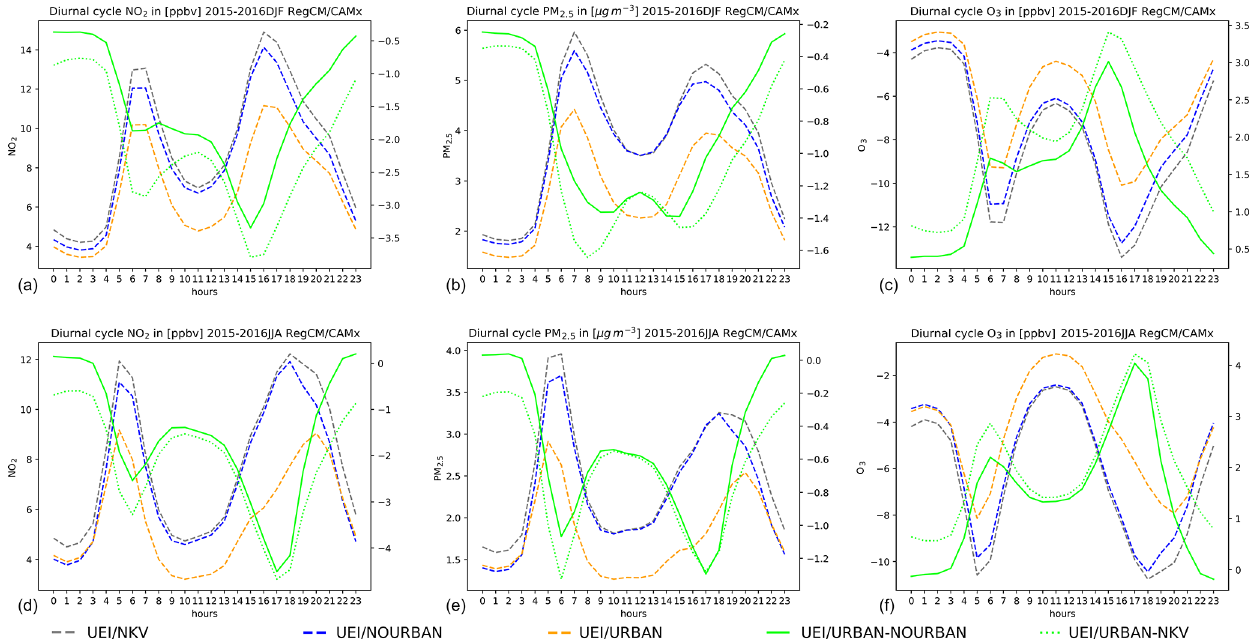
Figure 15. Impact of considering the vertical eddy diffusion (Kv) on the urban emission impact ( (cid:49) UEI) calculated from RegCM/CAMx simulations for DJF (a–c) and JJA (d–f) for NO 2 (a, d) , PM 2 . 5 (b, e) and O 3 (c, f) . Dashed grey, blue and green lines stand for the UEI calculated from the NKV, NOURBAN and URBAN cases, respectively, and belong to the left y axis. Solid and dotted green lines denote the (cid:49) UEI as the difference between the URBAN and NOURBAN and between the URBAN and NKV cases. Gases is in parts per billion volume (ppbv) and PM 2 . 5 in micrograms per cubic meter (µgm − 3